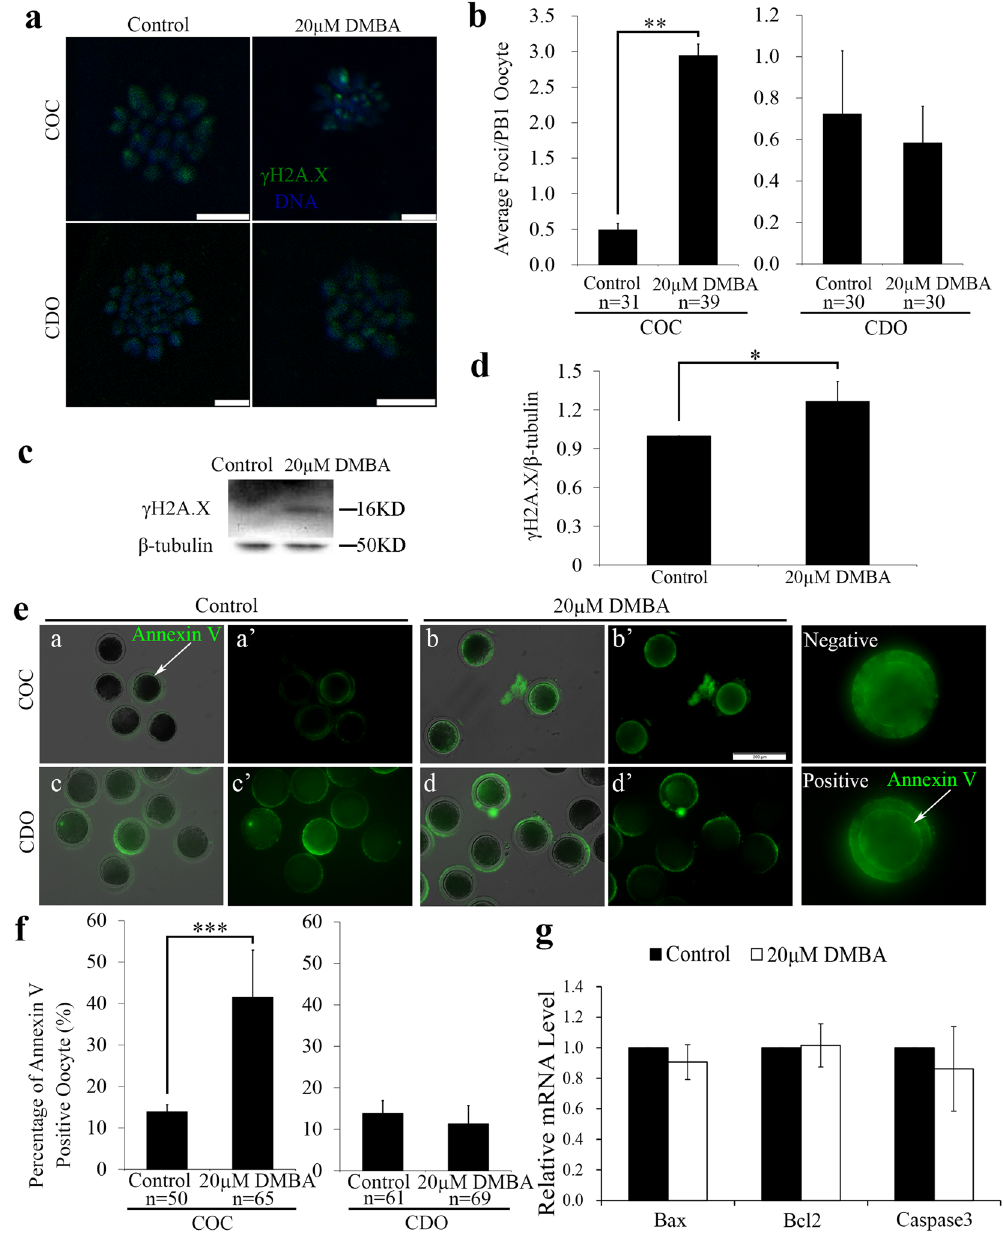
Figure 3. DMBA induced DNA damage and apoptosis in mature oocytes from COCs. ( a ) Representative images of γ H2A.X immunostaining. Scale bar, 500 μ m. ( b ) Average number of DSB foci per mature oocyte. ( c ) The lysates of 200 oocytes collected at 44 h from control and DMBA treated COCs were subjected to western blot analysis and bands of γ H2A.X and β -tubulin were cropped out of blot to display (full-length blot as shown in Supplementary Fig. S3). ( d ) Relative quantification of γ H2A.X protein level. ( e ) Representative images of Annexin-V staining (green) in mature oocytes. Scale bar, 200 μ m. ( f ) Percentages of apoptosis positive oocytes. ( g ) The relative mRNA level of Bax, Bcl2 and Caspase3 in mature oocytes. * P < 0.05; ** P < 0.01 and *** P <